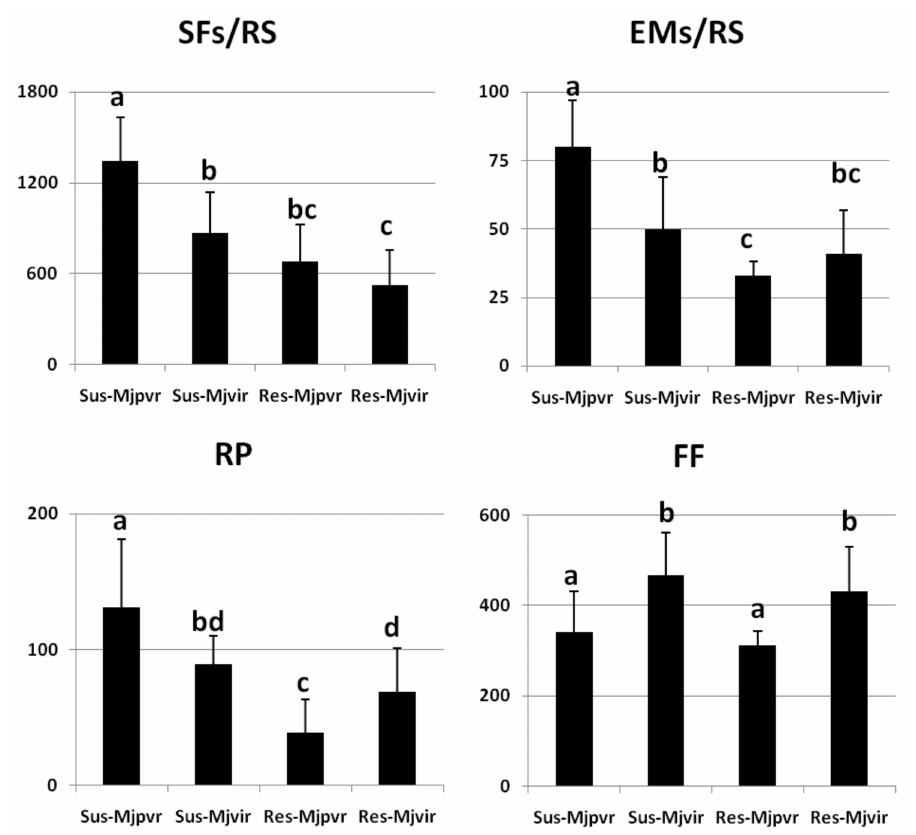
Figure 3. Infection factors of susceptible and resistant tomato plants inoculated with the partially virulent Meloidogyne javanica field population Mj-Tunc2field and the selected virulent isolate SM11C2 . Infection factors of four interactions are shown: Roma VF / Mj-TunC2field (Sus-Mjpvr); Roma VF / SM11C2 (Sus-Mjvir); Rossol / Mj-TunC2field (Res-Mjpvr); Rossol / SM11C2 (Res-Mjvir). Infection level was characterized by the numbers of Sedentary Forms per Root System (SFs / RS), Egg Masses per Root System (EMs / RS), Reproduction Potential (RP), and Female Fecundity (FF). Values are expressed as means ( n = 9) ± standard deviations. Means were separated by a Duncan’s Test (Significance Level: